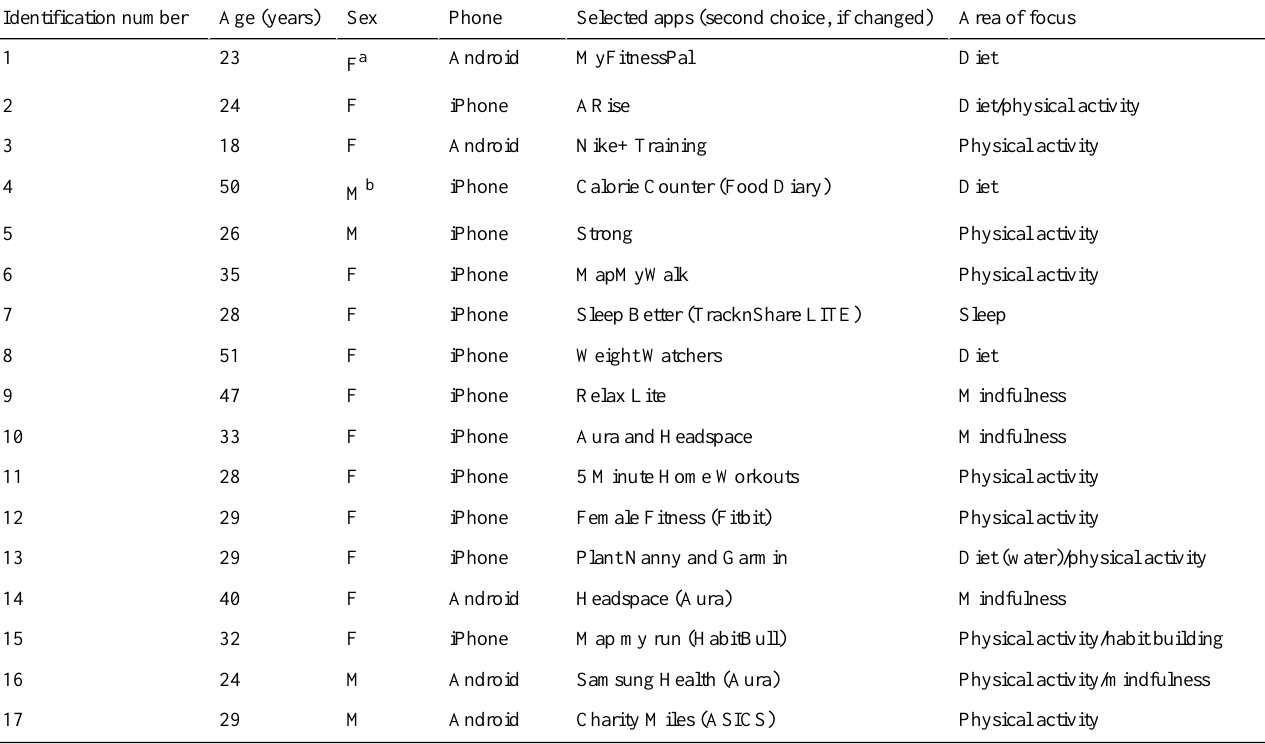
Table 1. Study participant characteristics and